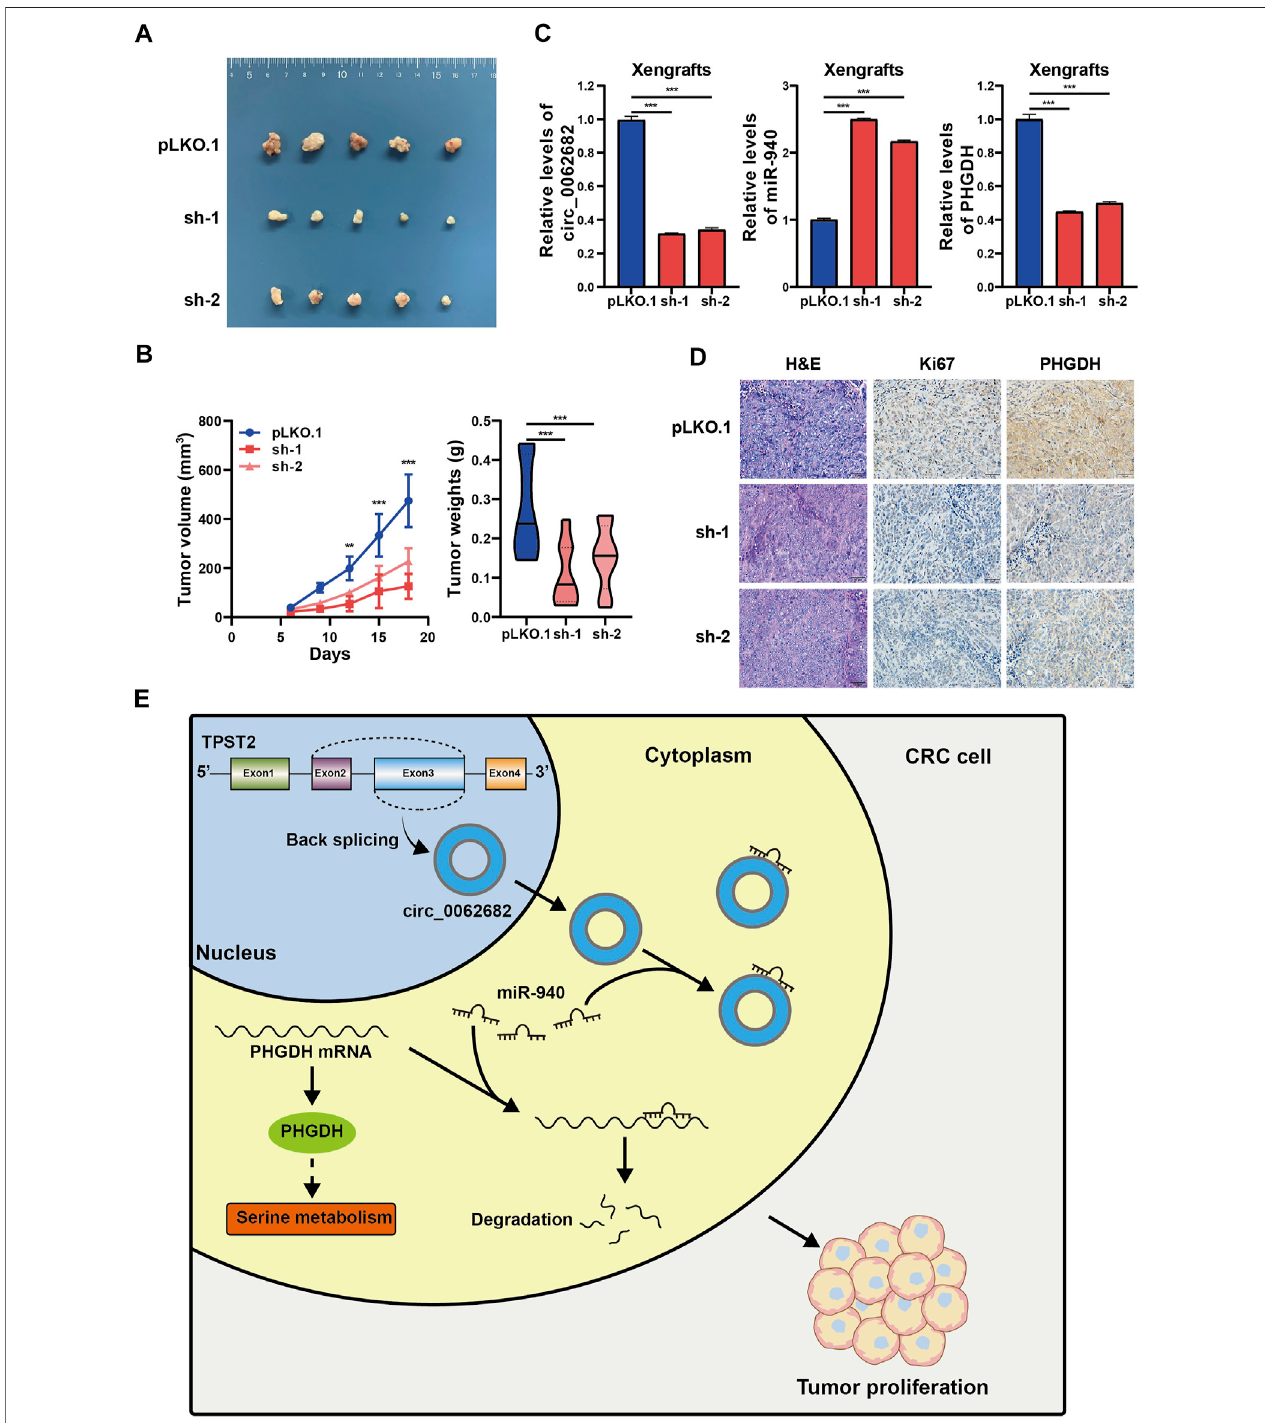
FIGURE 6 | Circ_0062682 knockdown inhibits CRC growth in vivo . (A,B) DLD1 cells with stable knockdown of circ_0062682 were injected subcutaneously into nude mice ( n (cid:2) 5) to evaluate the effect of circ_0062682 knockdown on tumor formation (A) . The tumor volumes were measured every 3 days and the tumor weights were recorded after mouse sacri fi ce (B) . (C) The expression levels of circ_0062682, miR-940, and PHGDH mRNA were measured in resected xenografts from (A) by qRT-PCR. (D) The protein expression of Ki67 and PHGDH in xenografts was detected by IHC staining. (E) A mechanistic model depicting the growth-regulatory role of the circ_0062682/miR-940/PHGDH axis in CRC.* p < 0.05; ** p < 0.001; *** p < 0.001.